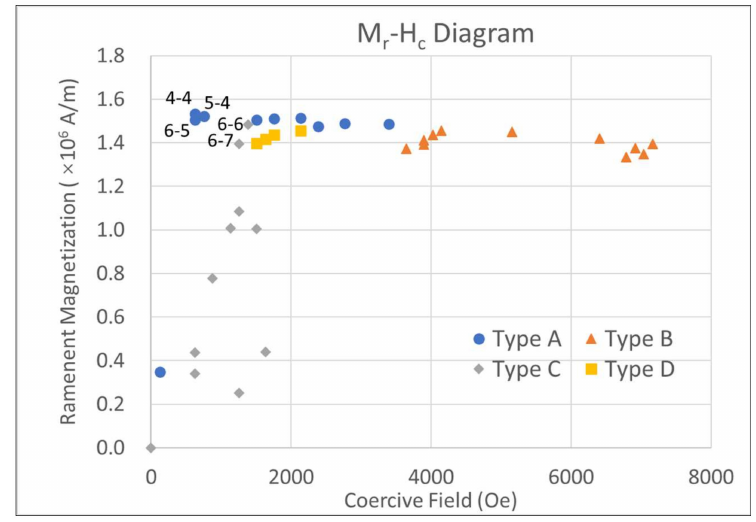
Figure 5. The remanent magnetization-coercive field (M r –H c ) diagram for the core-shell FePt/Fe composite. Solid circles, triangles, diamonds, and squares denote the M r and H c of loops of type A–D in Figure 3, respectively. Some key structures with their geometric structure (FePt radius-Fe thickness, in the unit of nm, e.g., 4–4 represents a composite structure with a core of 4 nm radius and a shell of 4 nm thickness) are also noted in the